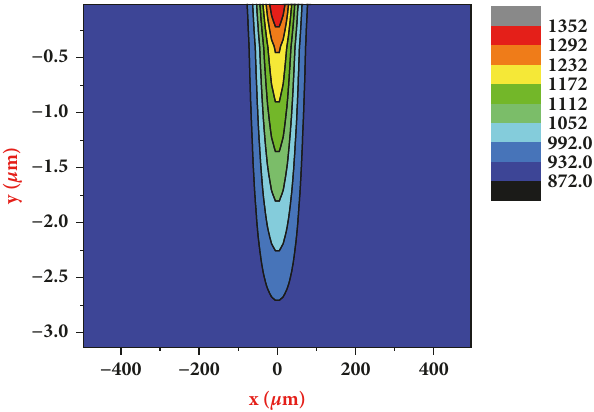
Figure 8: Temperature distribution of the Si 0.2 Ge 0.8 /Si virtual sub- strate simulated by COMSOL